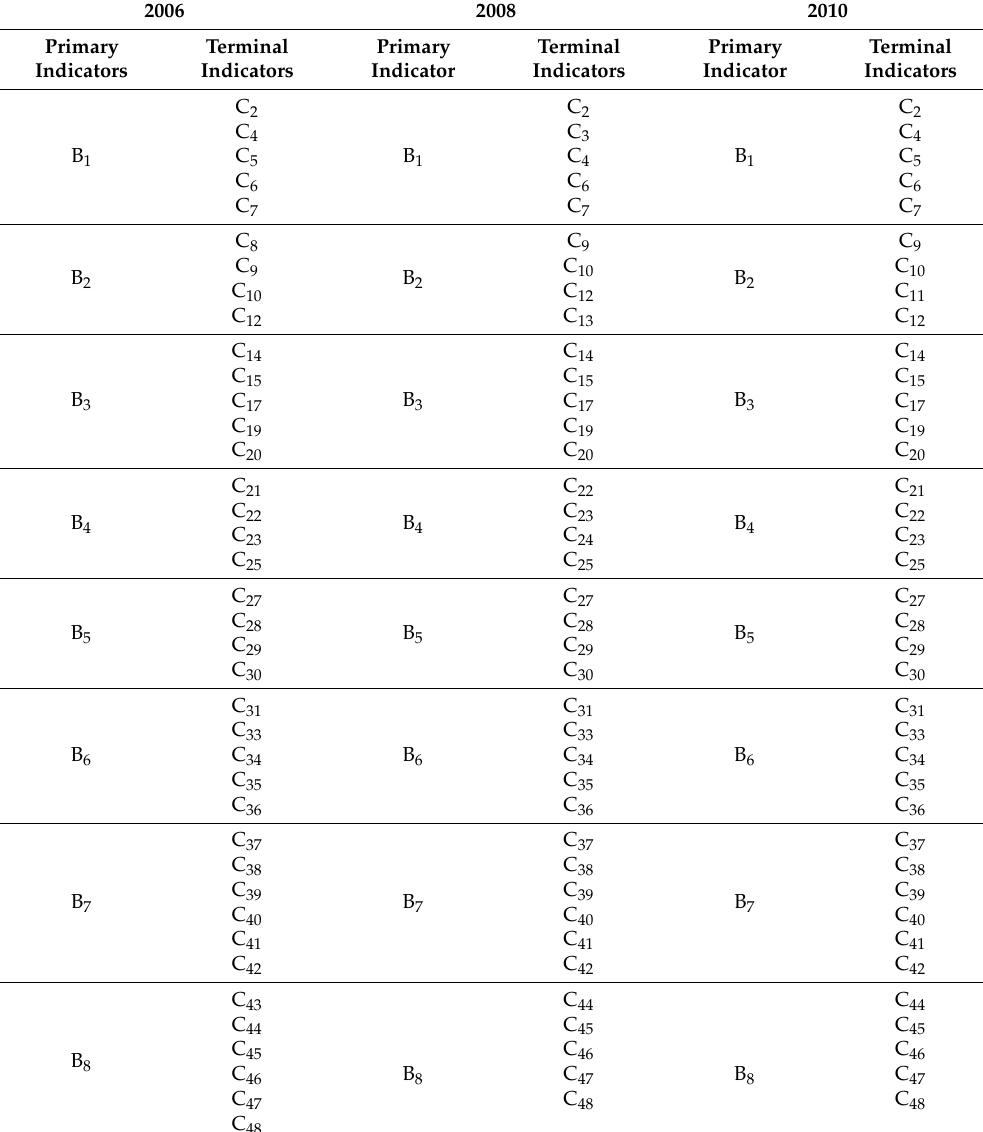
Table 10. Dynamic indicator system of the urban comprehensive carrying capacity of Harbin